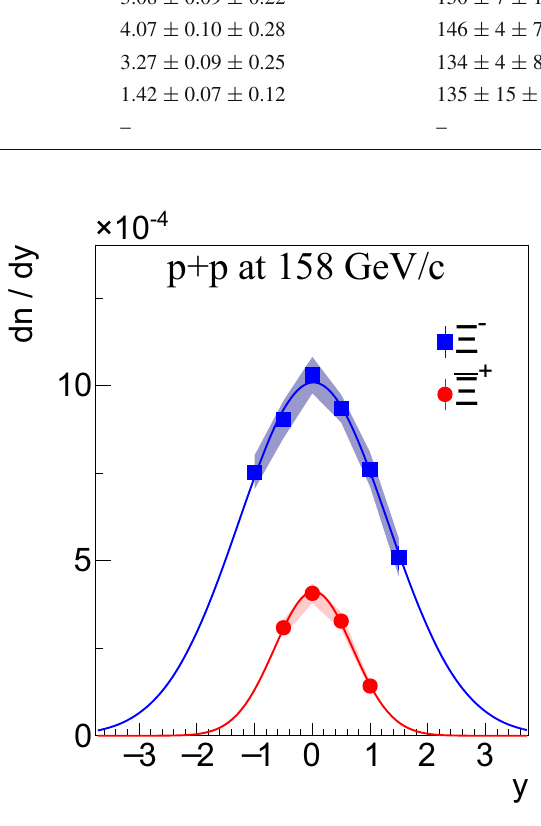
Fig. 5 Rapidity spectra of (cid:2) − (blue squares) and (cid:2) + (red circles) produced in inelastic p+p interactions at 158 GeV / c . Statistical uncer- tainties are smaller than the marker size, shaded bands correspond to systematic uncertainties of the measurements. Curves depict Gaussian fits used to determine total mean